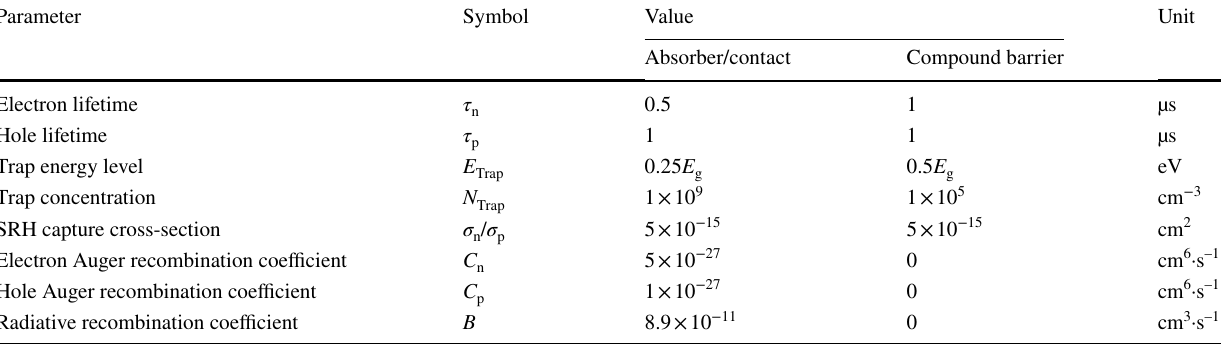
Recombination and defect parameters of the nBn photodetector used in the simulation